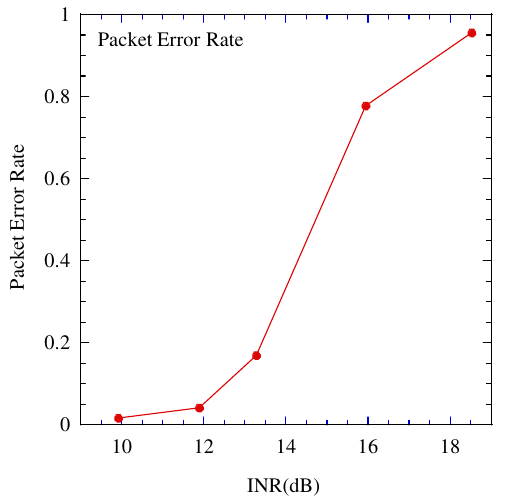
Figure 10. Performance between the packet error rate in the tentative demodulation of LoRa and the interference to noise power ratio